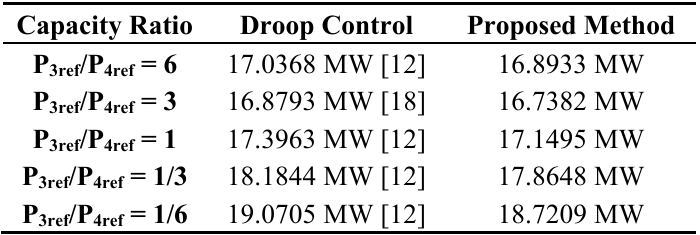
Table 3. Copper loss of VSC-HVDC (without local load).